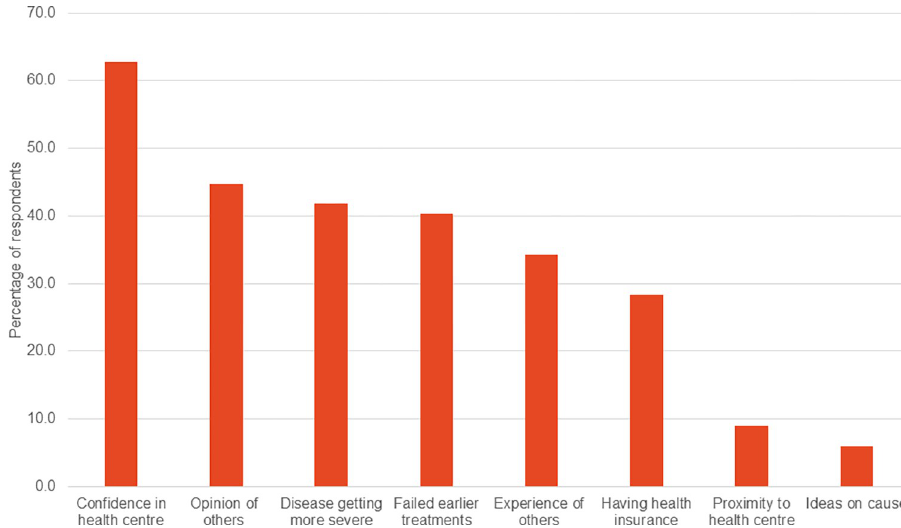
Fig 4. Facilitators of care seeking in the formal health system by participants in the scabies group.